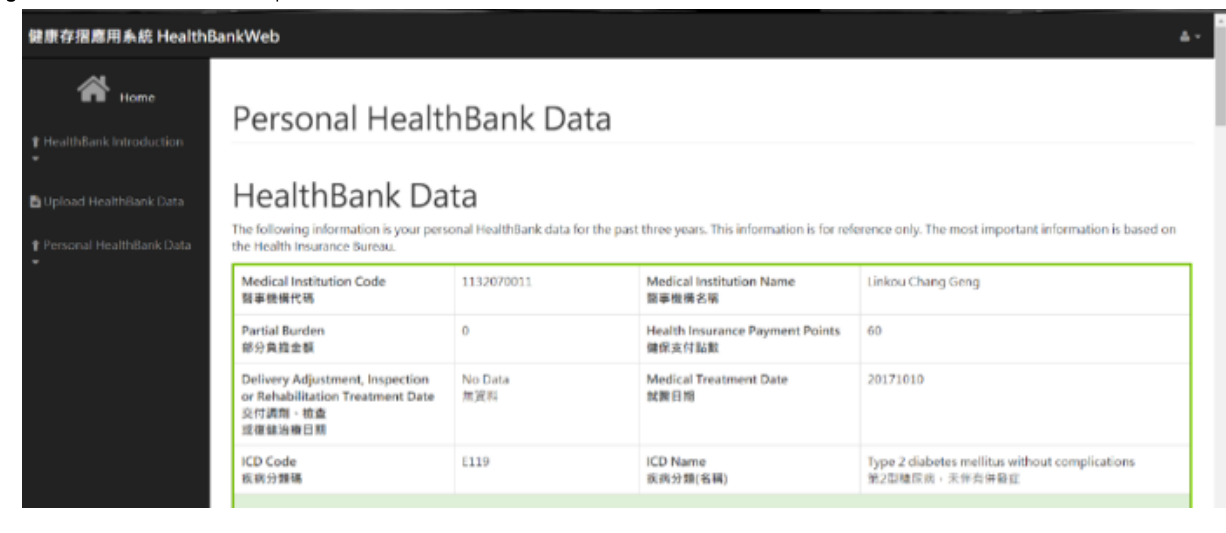
Figure 8. The user interface of a personal health record